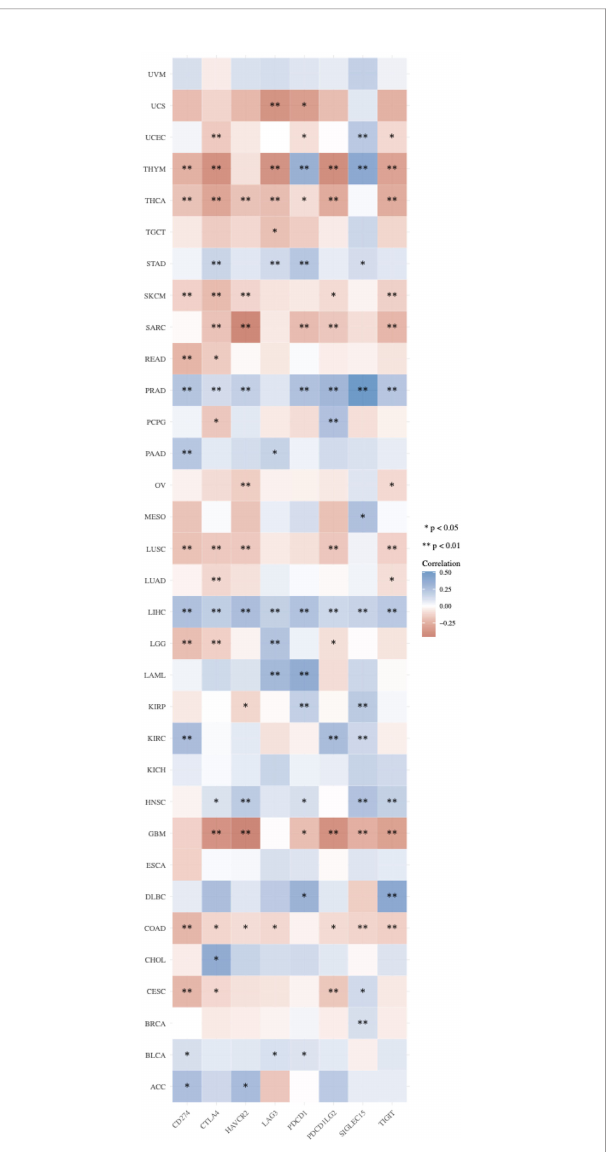
FIGURE 6 | Correlation between PCIF1 and immune checkpoint genes in TCGA tumors. * p < 0.05; ** p <